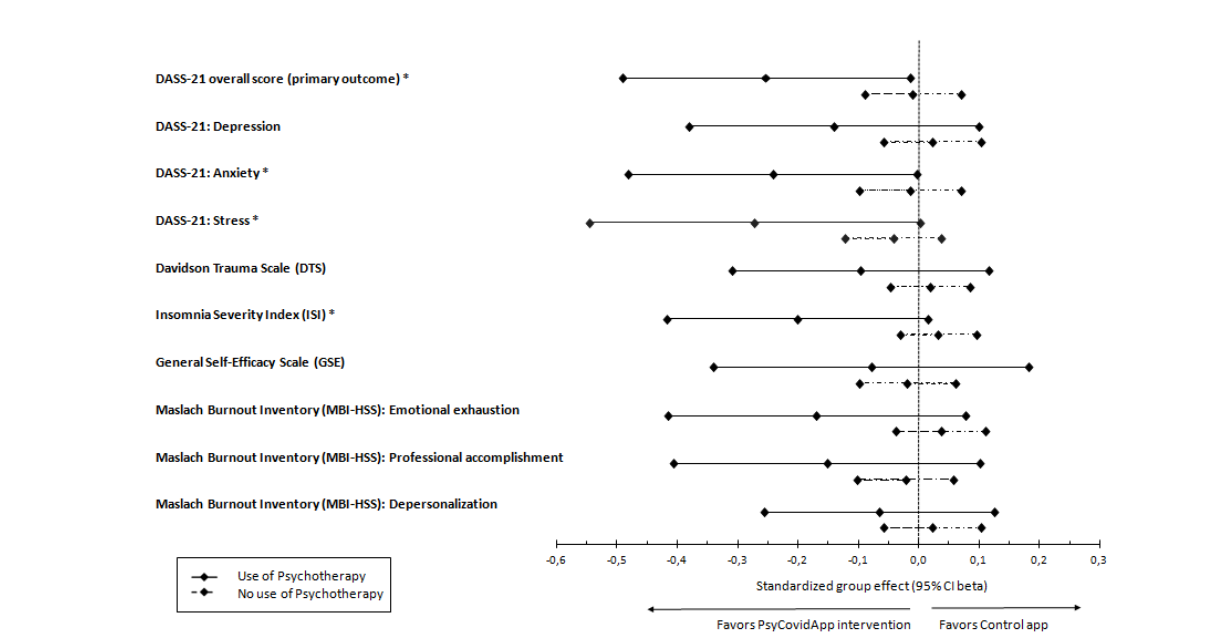
Figure 4. Standardized mean differences for primary and secondary outcomes in health care workers reporting the use of psychotherapy at baseline. Forest plot of standardized group differences between the PsyCovidApp and Control App groups for all outcomes, whereby an effect lower than 0 favored the PsyCovidApp group. Error bars show 95% CIs. DASS-21: Depression, Anxiety, and Stress Scale. * P <.05.